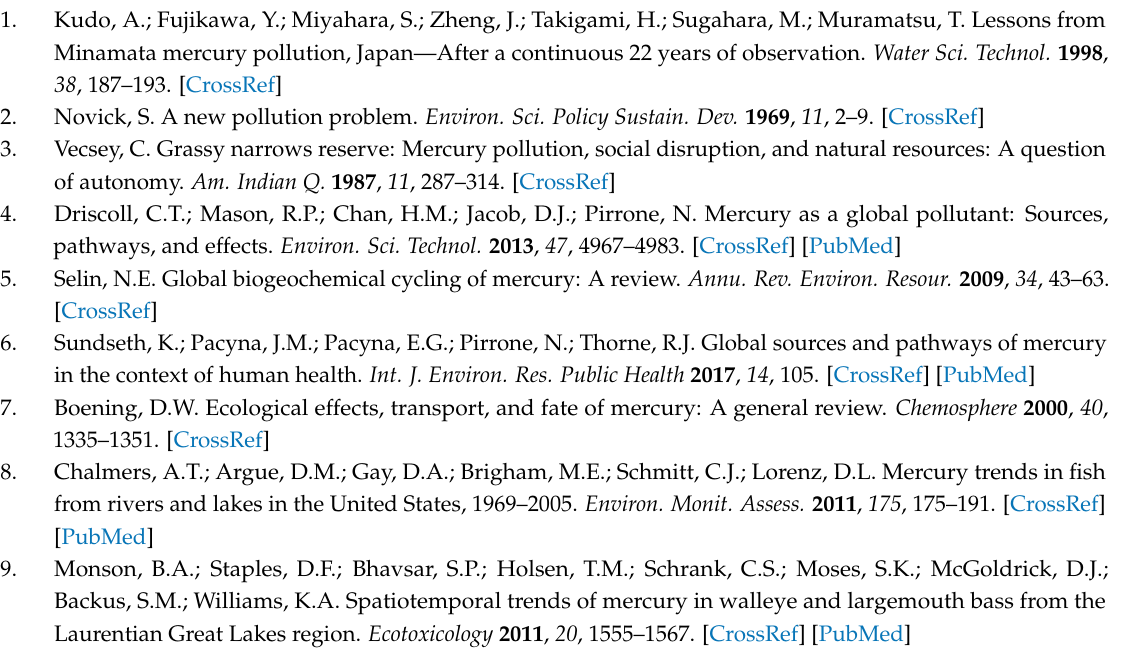
s1, Figure S1. Correlation between fish body mass and body length in Walleye (left) and Northern Pike